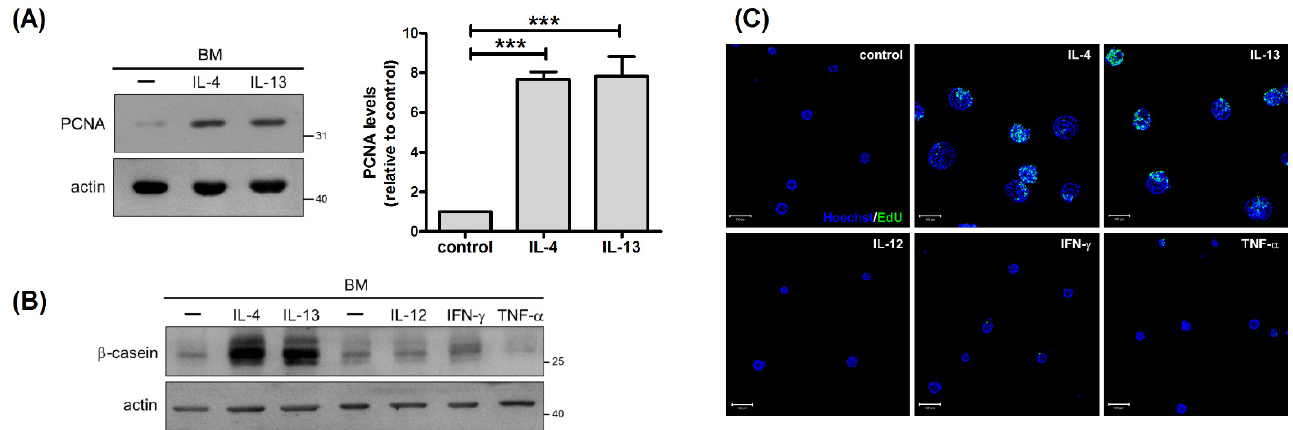
Figure 2. IL-4 and IL-13 promote proliferation of mammary cells. ( A ) Mammary cells cultured on a basement membrane (BM)-like matrix, Matrigel, were untreated or treated with IL-4 or IL-13 for 2 d. Total cell lysates were analyzed by immunoblotting with antibodies to PCNA and actin. Actin was used as a loading control. Data were quantified, normalized to loading control and expressed as fold change relative to control ( n = 4). *** p < 0.005. ( B , C ) Cells were untreated or treated with IL-4, IL-13, IL-12 (20 ng/mL), IFN- γ (10 ng/mL), or TNF- α (10 ng/mL) for 2 d. ( B ) Total cell lysates were analyzed by immunoblotting with antibodies to β -casein and actin. ( C ) Prior to harvesting, cells were pulsed with EdU (10 µ M; green) for 8 h. Nuclei were stained with Hoechst 33342 (blue). Scale bar, 100 µ m. In these images, clusters of nuclei indicate cells within mammary acini, and IL-4 and IL-13 stimulate EdU incorporation into cells within mammary acini.